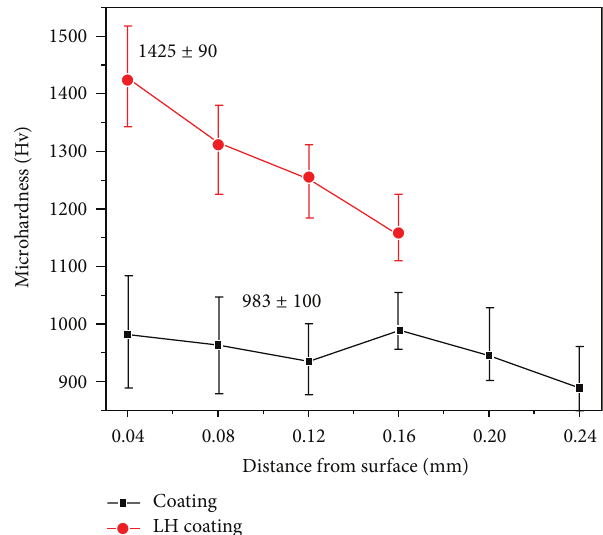
Figure 3: Depth profiles of surface hardness of coating and LH coating.